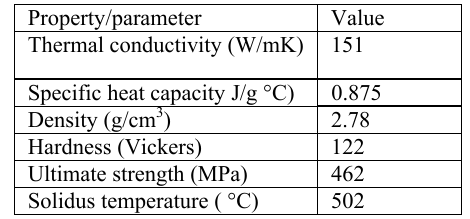
Table 1. Mechanical and thermal properties of base metal (AA2024-T3)